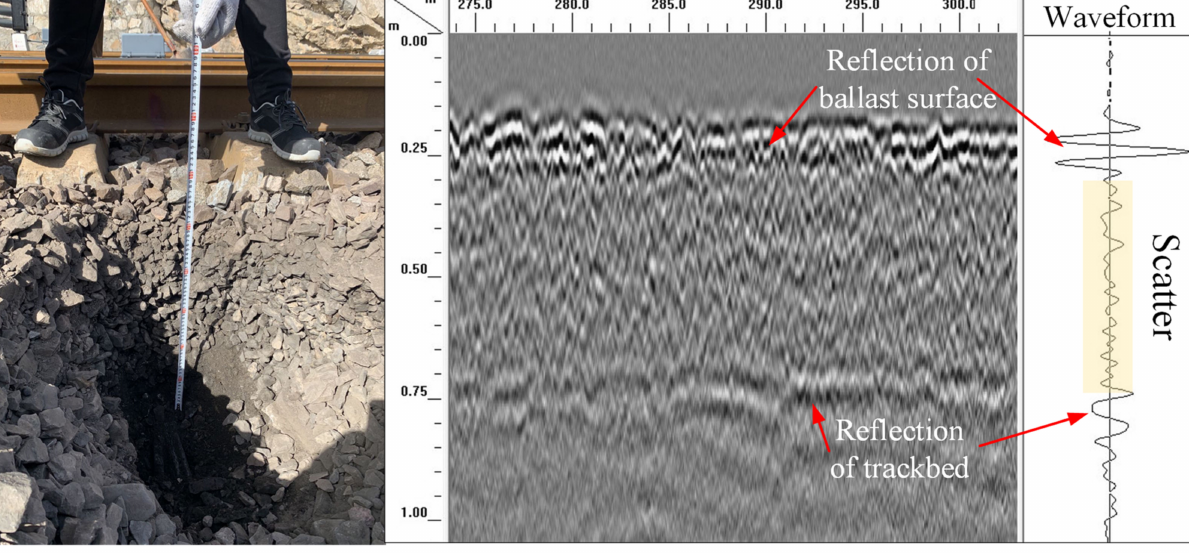
Figure 8. GHz ballast layer GPR signal